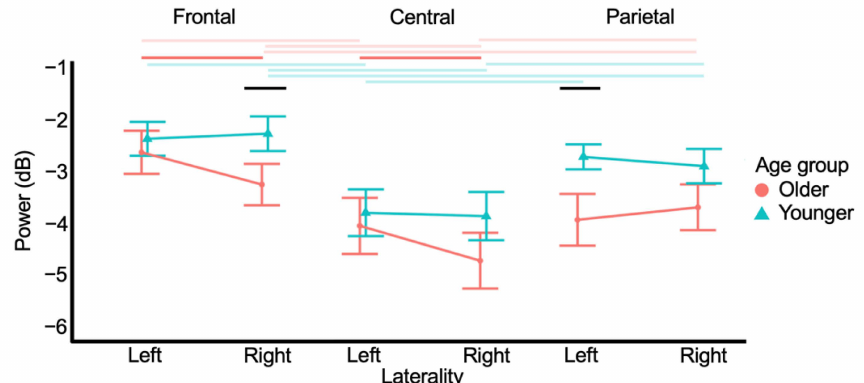
Figure 6. Interaction plots for movement-related beta desynchronization (MRBD) during motor execution. Lower values represent more MRBD. MRBD was higher in older adults, consistent with Hypothesis 2. Partially in line with Hypothesis 3, MRBD was higher in the frontal and central right versus left regions in older adults. Opposed to Hypothesis 4, hemispheric laterality was only present in older adults. Error bars display the 95% confidence interval. Horizontal lines denote significant contrasts with colored and black lines indicating within-group and between-group differences, respectively. Between-hemisphere significant contrasts are visualized brighter than between-region